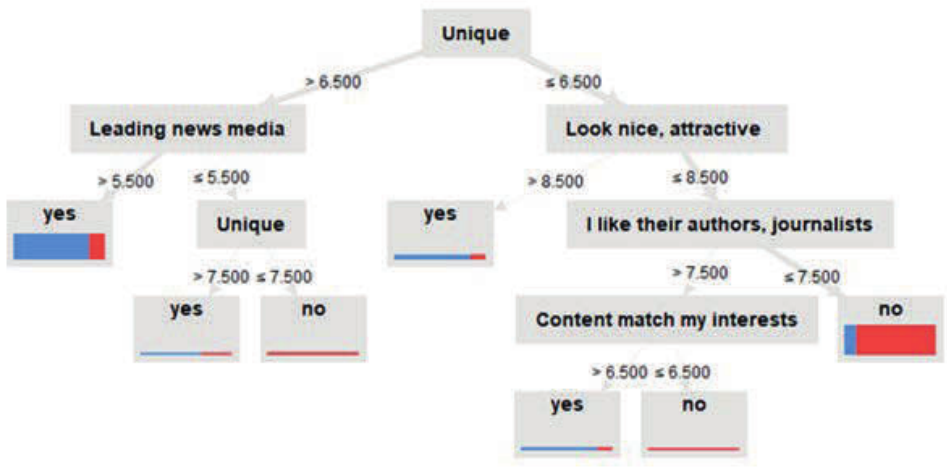
Fig . 1. Delfi.lv brand uniqueness impact on delfi.lv brand equity, decision tree test, Rapid Miner